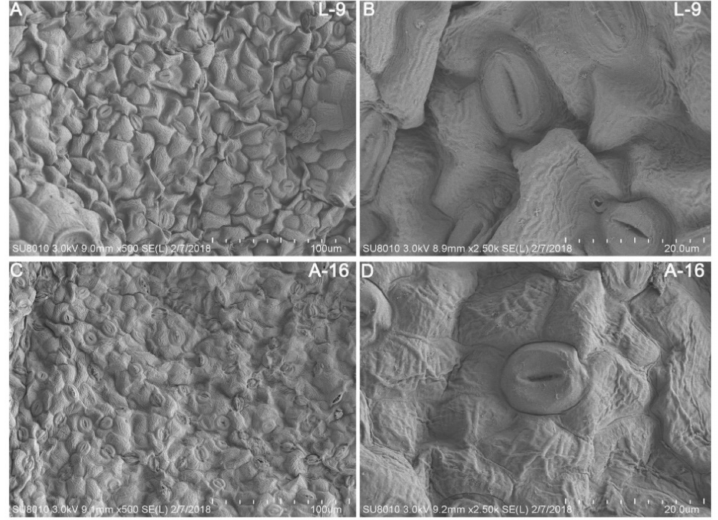
Figure 3. SEM observation of L-9 and A-16 leaves at seedling stage. ( A , B ) Scanning electron microscopy (SEM) images of leaves in L-9. ( C , D ) Scanning electron microscopy (SEM) images of leaves in